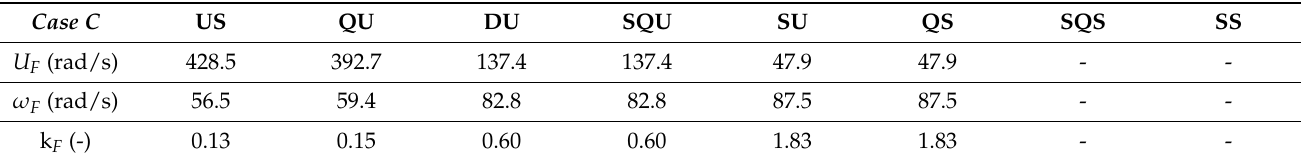
Table 5. Flutter analysis results for Case C using different aerodynamic models; elastic axis at midchord.